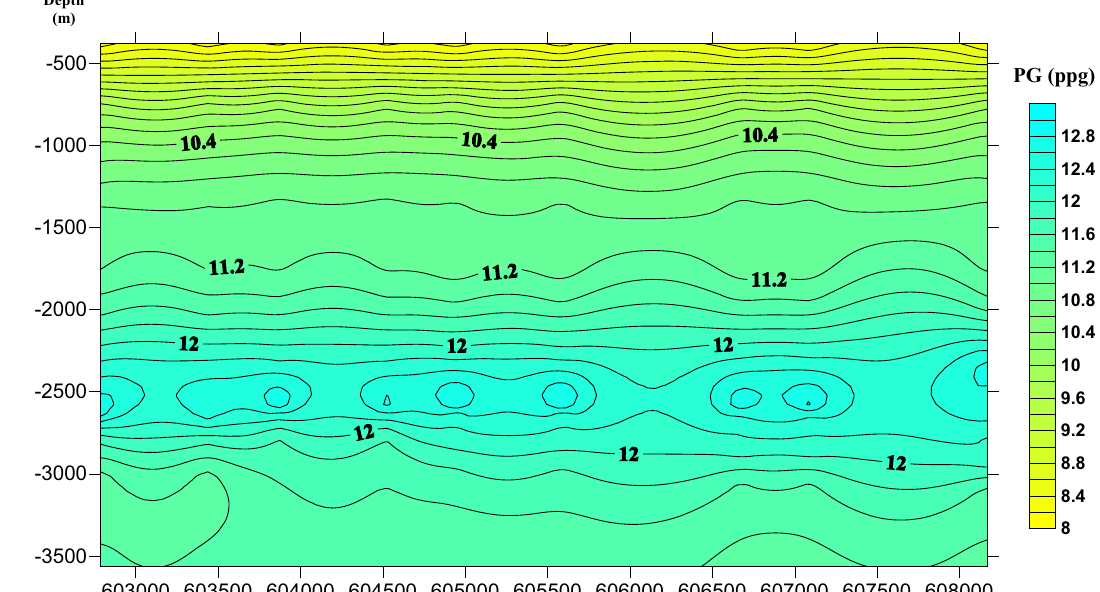
Fig. 14 2D pore pressure gradient model along inline